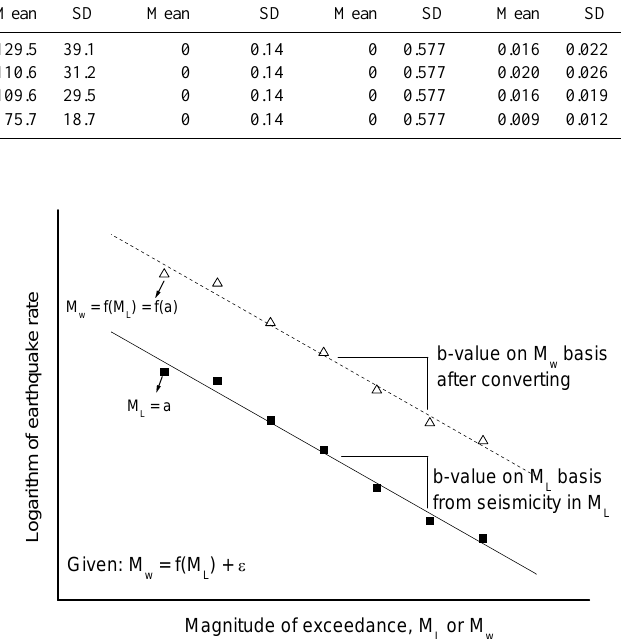
Fig. 8. A schematic diagram illustrating a procedure to obtain a b -value on an M w basis from given seismicity in M L . must be performed beforehand. Figure 8 is a schematic dia- gram showing a possible procedure to obtain the b value on an M w basis, converted from the M L -based b value. Under- standably, this conversion simply applied an empirical model (e.g., Eq. 1) to each data point in the log N - M diagram (i.e., Fig. 8), then calculating the slope of converted data